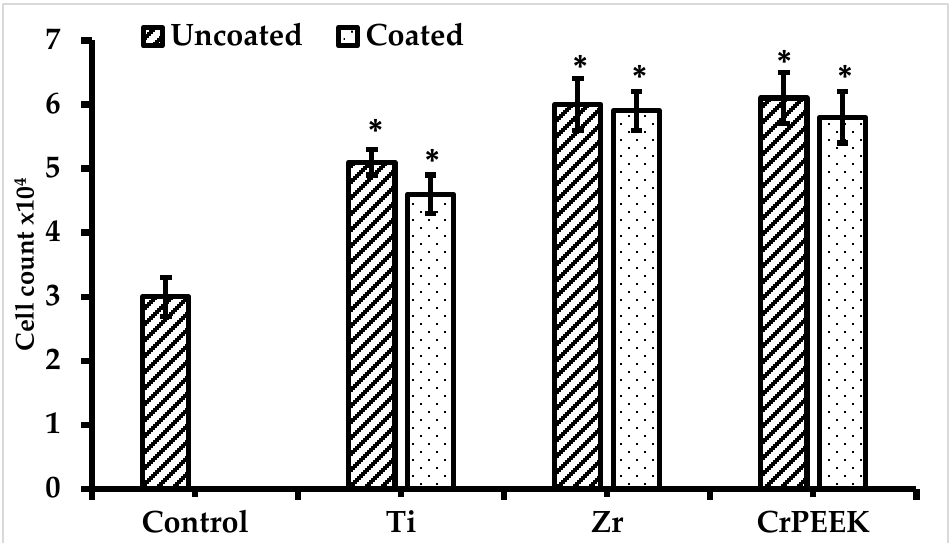
Figure 8. B-hMSC cell proliferation rate at one week. Control cells without biomaterials. TI, Zr, and CrPEEK represent cells cultured on titanium, zirconium, and ceramic-reinforced PEEK, respectively. Values are mean + standard deviation, and * denotes statistical significance, p < 0.05 vs. control .